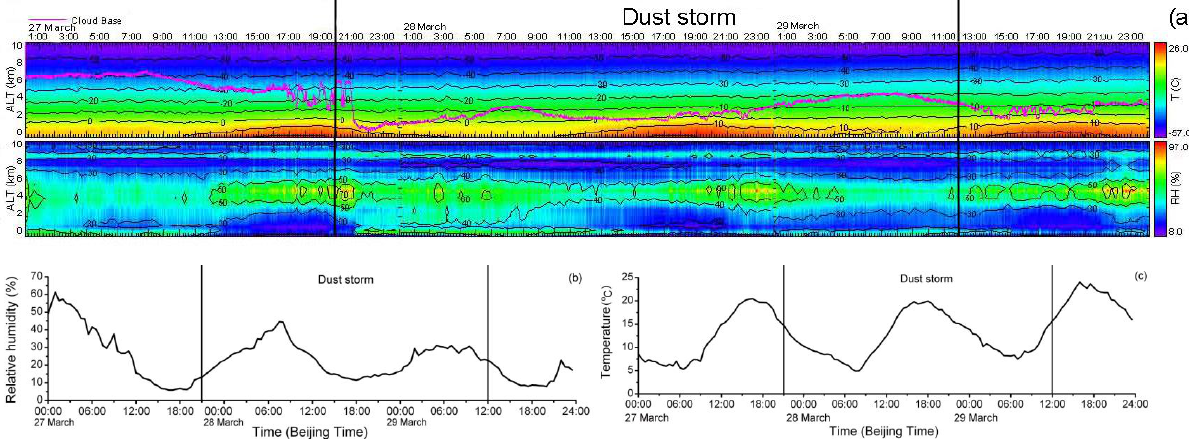
Fig. 4. Temporal evolutions of (a) relative humidity and temperature vertical section, (b) surface relative humidity, and (c) surface tempera-